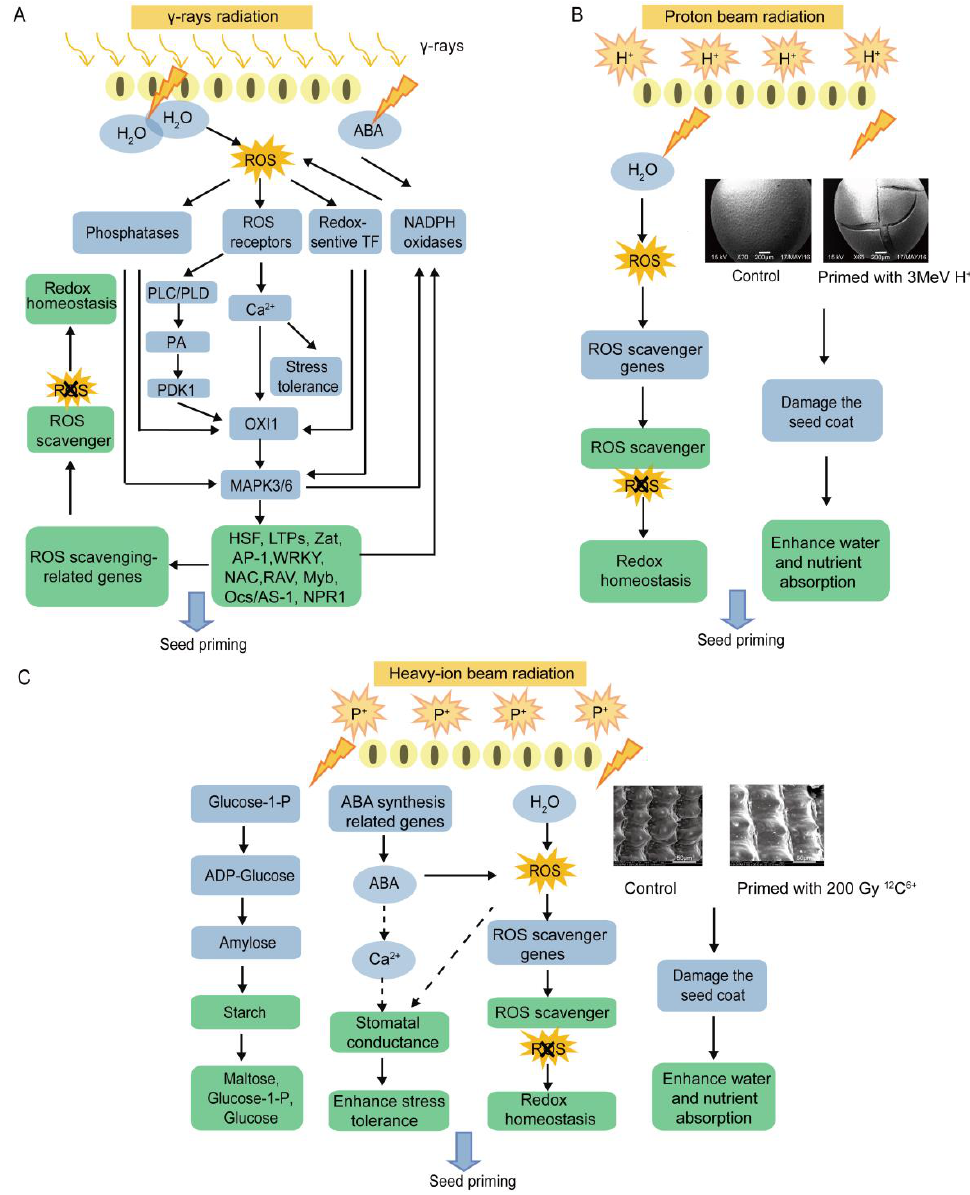
Figure 5. ( A ) Effect of γ -rays on seed germination, the ROS is accepted by ROS receptors after being generated by water radiolysis. Subsequently, oxidative signal-inducible kinase (OX) is regulated by phosphoinositide-dependent kinase (PDK) or the signaling molecular Ca 2+ , and after that, OX will regulate transcription factors (TFs) by changing into mitogen-activated protein kinase (MAPK) to further amplify the defense signaling after irradiation. These TFs include heat shock factor (HSF), LTP family protein (LTPs), zinc finger protein (Zat), apetala-1 (AP-1), WRKY DNA-binding protein (WRKY), NAC family (NAC), the regulator of the atpase of the vacuolar membrane (RAV), Myb domain protein (Myb), and others. As a consequence, the genes associated with ROS scavenging and metabolites associated with scavenging surplus free radicals are produced to maintain the op- timal redox status in plants. In add ition, γ -ray irradiation upregulates the related genes to accu-